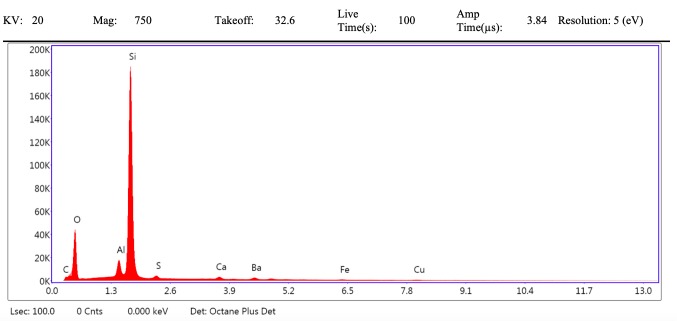
EDS spectrum of vessel (spot 1) from demineralised Late Cretaceous Centrosaurus bone area B.